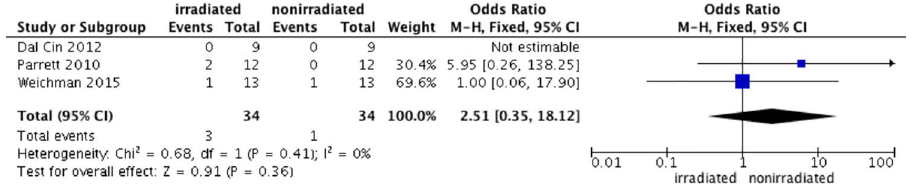
Fig 9. Correlations between radiation and fat